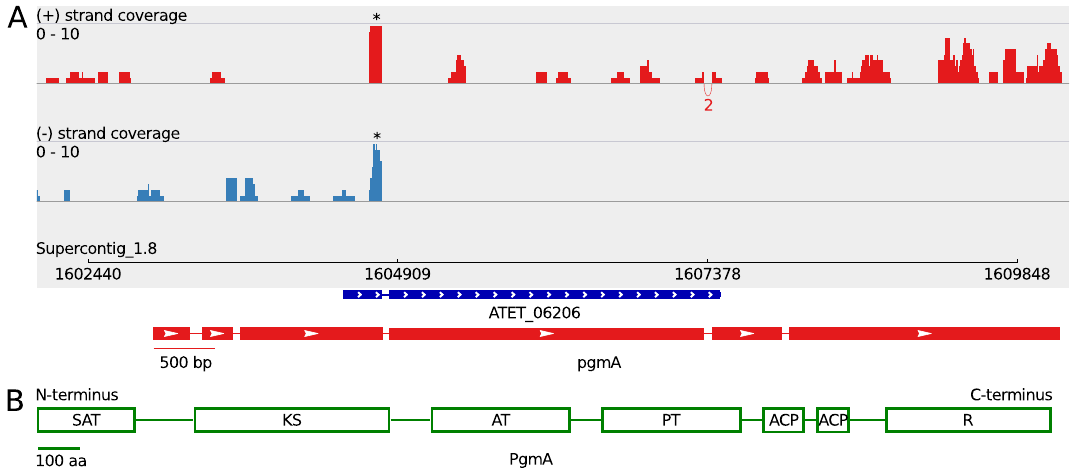
Figure 1. The predicted non-reducing polyketide synthase PgmA. ( A ) sashimi plot of the pgmA gene describing the strand-specific alignment coverage of the read sequences of A. terreus MUCL 38669 over the corresponding genomic region of NIH2624 supercontig_1.8, which was obtained using the Integrative Genomics Viewer (IGV) software [29–31]. The curved splice junctions represent the number of spliced reads indicating an intron at that specific location. The predicted gene structure is shown below the sashimi plot in the same scale as the plot; ( B ) the predicted protein domains of the translated sequence of PgmA: Starter unit:ACP transacylase (SAT), Beta-ketoacyl synthase (KS), Acyl transferase (AT), Polyketide product template (PT), Acyl carrier (ACP), Thioester reductase (R). * These